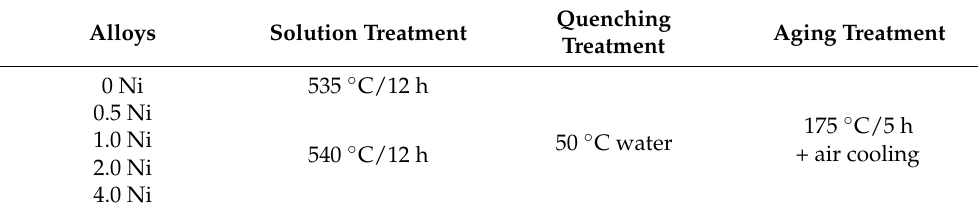
Figure 1. Heating curves of as-cast Al-8.4Cu-2.3Ce-1.0Mn-0.2Zr alloys with different Ni contents. The arrows with different colors indicate the onset melting temperatures of different alloys. Table 2. Summary of heat treatments performed on the cast alloys.